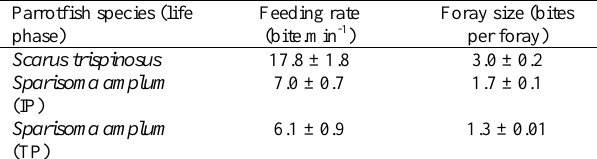
Table 2. Feeding rate and foray size of Scarus trispinosus and Sparisoma amplum . Values given are mean ± SE. IP - initial phase and TP - terminal phase individuals.